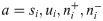
Mapping probability between regions.In the limit as time approaches infinity, the probability that a neuron will be found in the region s
a for a=si,ui,ni+,ni- is given by ||vsa||1. After the time mτ has elapsed, the probability that a randomly chosen neuron started in s
a and was mapped to s
b for b=si,ui,ni+,ni- is given by ||Pmτsa→sbvsa||1. Based on these relations, the above diagram gives an example characterizing how probability initially found in the region s
i is mapped to all other regions after the time mτ has elapsed.